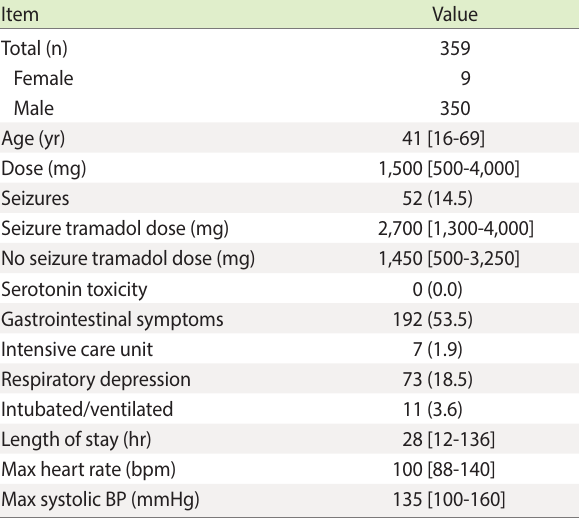
Table 1. Patients’ demographics and clinical